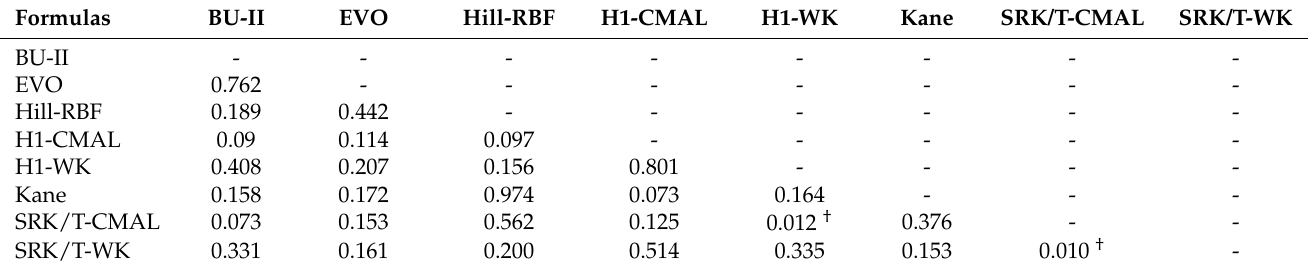
Table 3. Statistical analysis comparison of